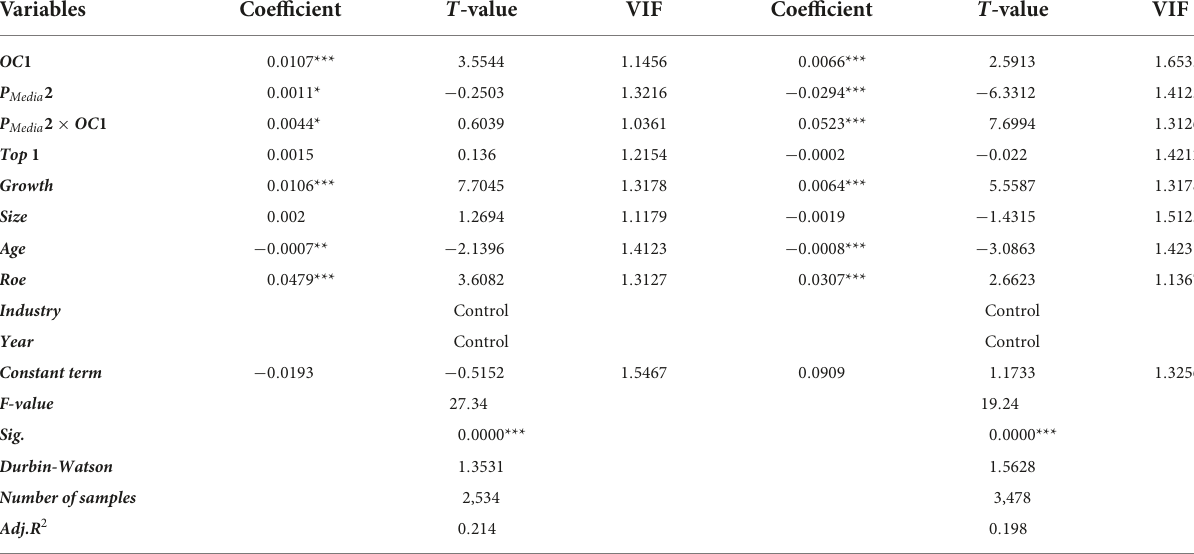
TABLE 11 Regression results of positive media reports under different